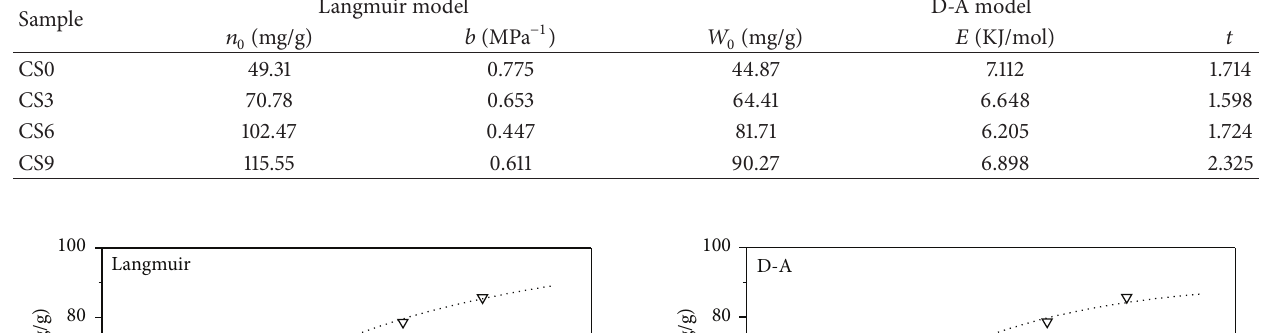
Table 2: Adsorption parameters of the Langmuir model and D-A model of methane adsorption at 298 K. Sample